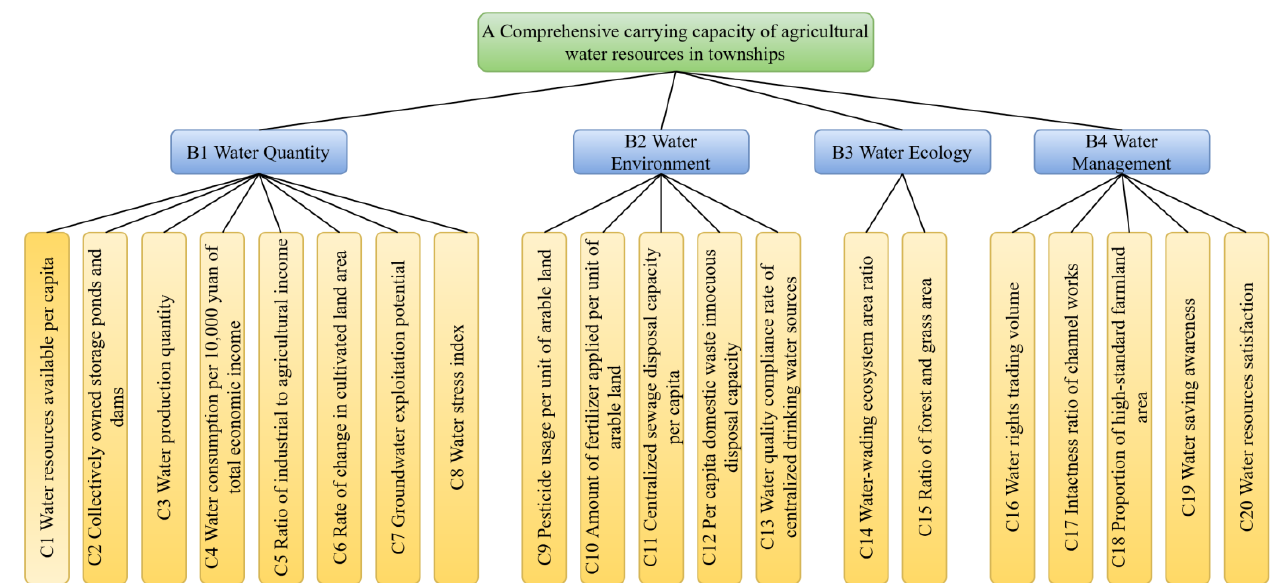
Figure A1. Evaluation hierarchy structure of WRCC for townships in Ganzhou district.